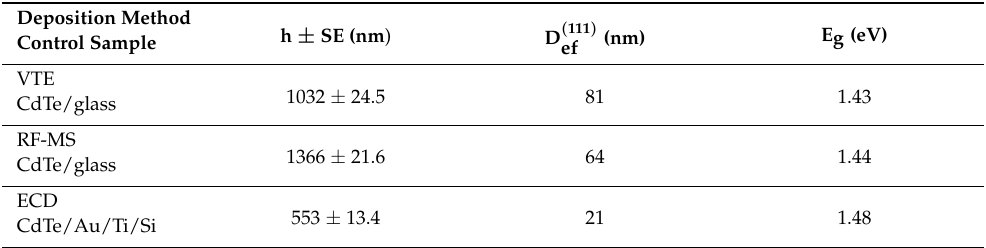
Table 3. Collection of morpho-structural data, showing the variation of the band gap energy (Eg) ( 111 ) with the crystallite size (D ) and film thickness (h) for the CdTe layers deposited by VTE, RF-MS, ef and ECD, respectively. Eg values are shown with an estimated accuracy of ± 0.01–0.03